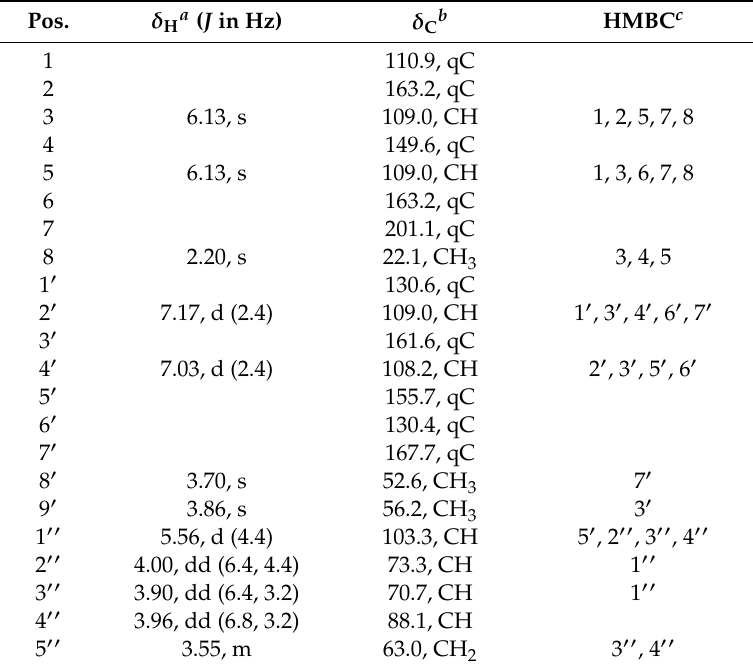
Table 2. NMR data for compound 7 (methanol- d 4